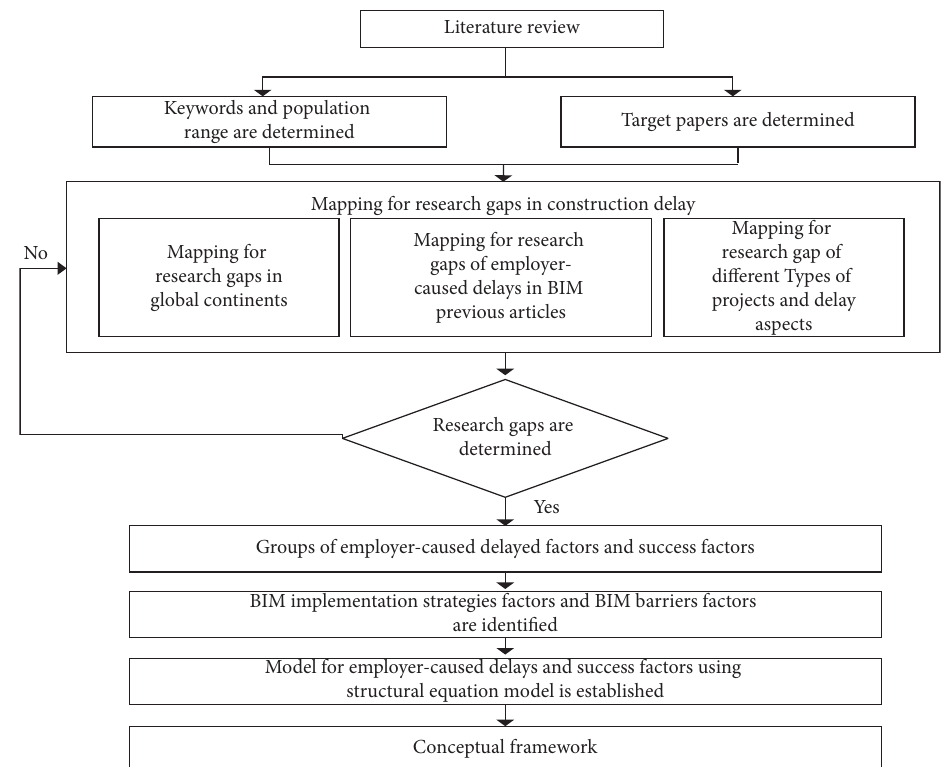
Figure 1: Research